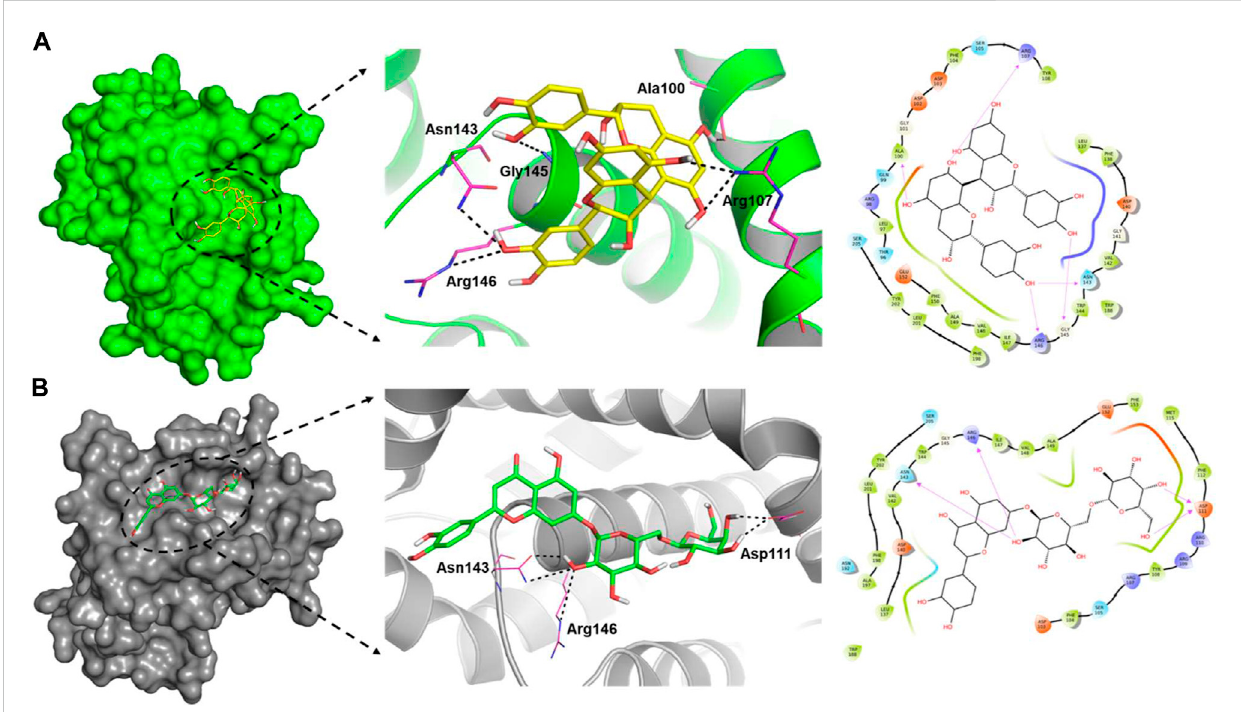
FIGURE 6 Surface view of the ligand-binding pocket (left), binding poses and interacting fragments (centre) and the H-bonds, hydrophobic interactions, van (cid:1) der Waal ’ s interactions around 4.0 Å of the binding cavity (right) of procyanidin B2 (A) and luteolin-7- O -rutinoside (B) with Bcl-2 (PDB ID: 5JSN).